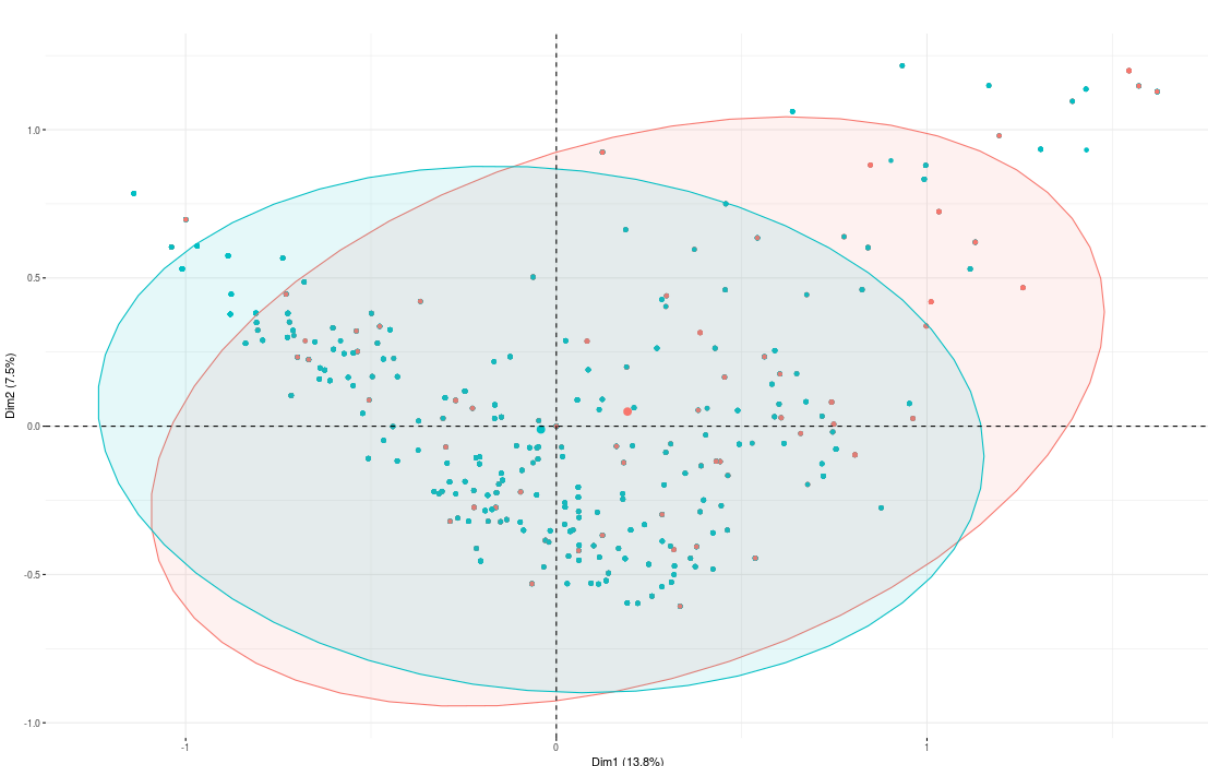
Figure 2. Projections of students into teachers’ problematization space. Notes: Points can represent two or several students if these students have the same values on all variables used to construe the MCA space. Red points represent students with foreign-born fathers, cyan points those with fathers born in